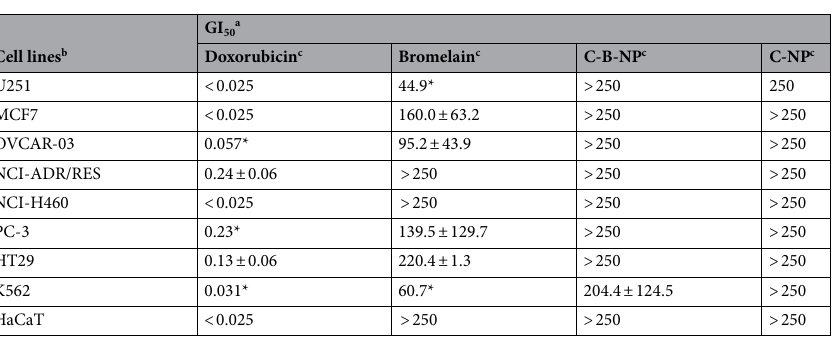
Table 1. In vitro antiproliferative effect, expressed as concentration required to 50% of cell growth inhibition (GI 50 , μg/mL) of doxorubicin (positive control), free bromelain solution, chitosan-bromelain nanoparticles (C-B-NP), and chitosan nanoparticles (C-NP) after 48 h-exposure. a Results expressed as growth inhibition 50 (in μg/mL) followed by standard error, calculated by sigmoidal regression using Origin 8.0 software; *approximated value (experimental data did not converge, standard error higher than the calculated effective concentration). b Human tumor cell lines: U251, glioblastoma; MCF-7, breast, adenocarcinoma; OVCAR- 03, ovary, adenocarcinoma; NCI-ADR/RES, ovary, multi-drug resistant adenocarcinoma; NCI-H460, lung, non-small cell carcinoma; PC-3, prostate, adenocarcinoma; HT-29, colon, adenocarcinoma; K562, chronic myeloid leukemia. Human non-tumor cell line: HaCaT, immortalized keratinocytes. c Samples: doxorubicin (chemotherapeutic drug; 0.025–25 μg/mL); bromelain (0.025–25 μg/mL, considering protein concentration); chitosan-bromelain nanoparticles (0.025–25 μg/mL, considering equivalent protein concentration of free bromelain); chitosan nanoparticles (0.025–25 μg/mL, considering equivalent amount of chitosan-bromelain